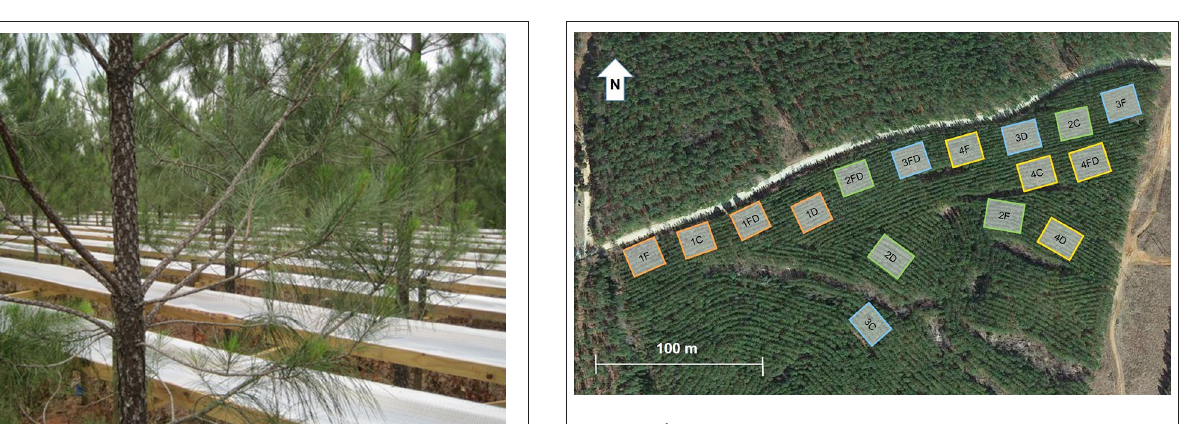
been effectively applied for exclusion experiments (Hanson et